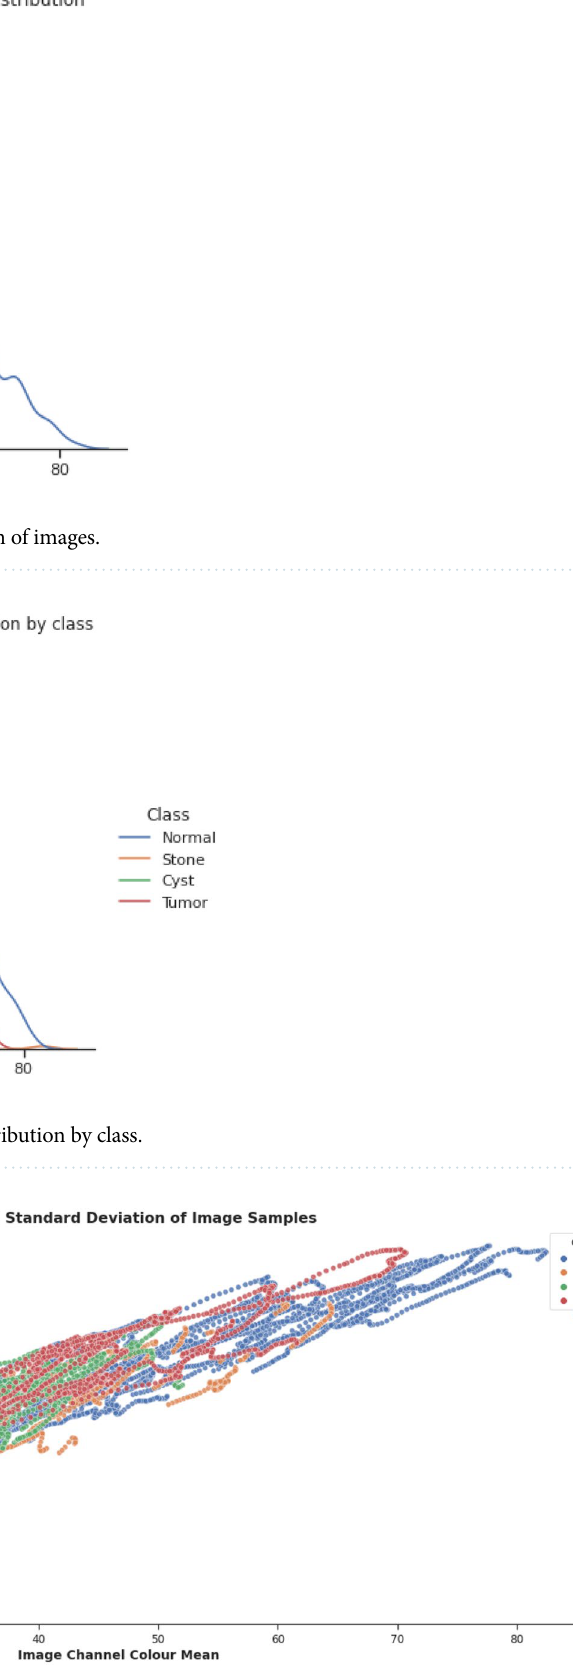
Figure 5. mean and standard deviation of Image